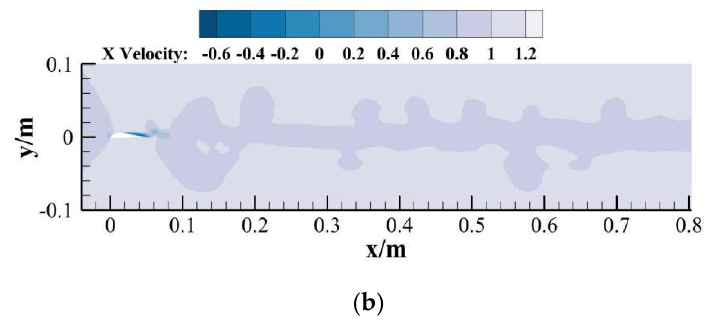
Figure 24. Comparison of contours of instantaneous velocity in the flow direction at 2.0 s between the two models: ( a ) the original hydrofoil and ( b ) the biomimetic hydrofoil.